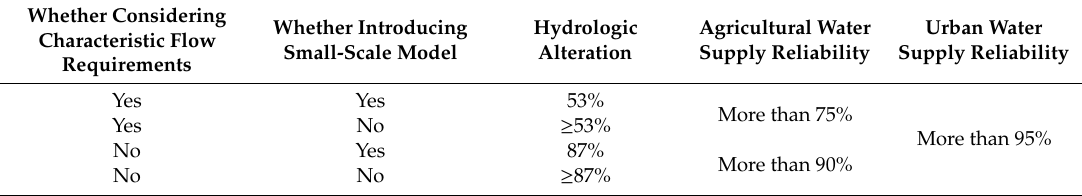
Table 4. Contrast of the degree of hydrologic